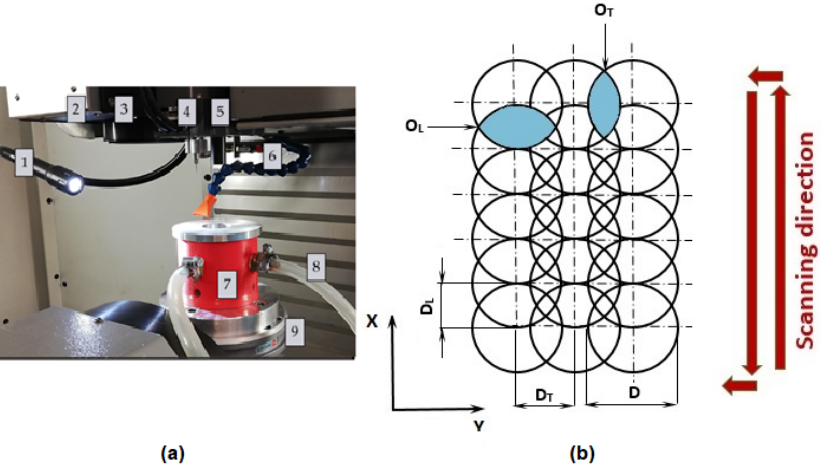
Figure 2. Experimental setup. ( a ) The main parts of the laser equipment; ( b ) scheme of pulse